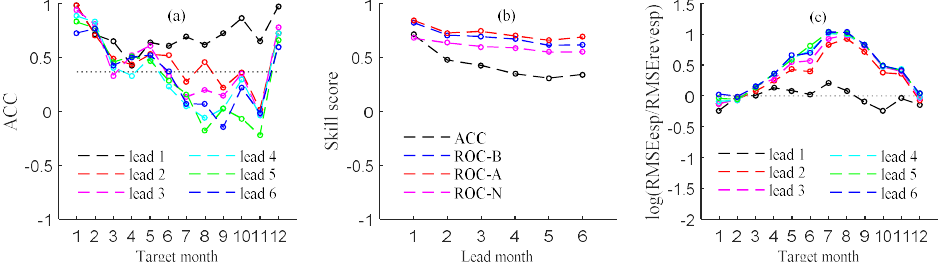
Figure 5. Variation of ( a ) ACC and ( c ) ratio of forecast to the observation variance with the target month for six lead times, and ( b ) skill scores variation with the lead time in terms of ACC and ROC areas for the Yangtze River.